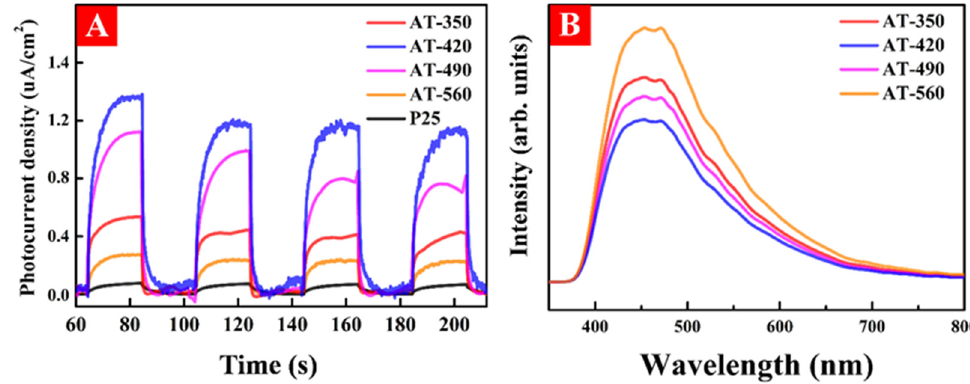
Figure 7. ( A ) The transient photocurrent density and ( B ) photoluminescence spectra for all samples.